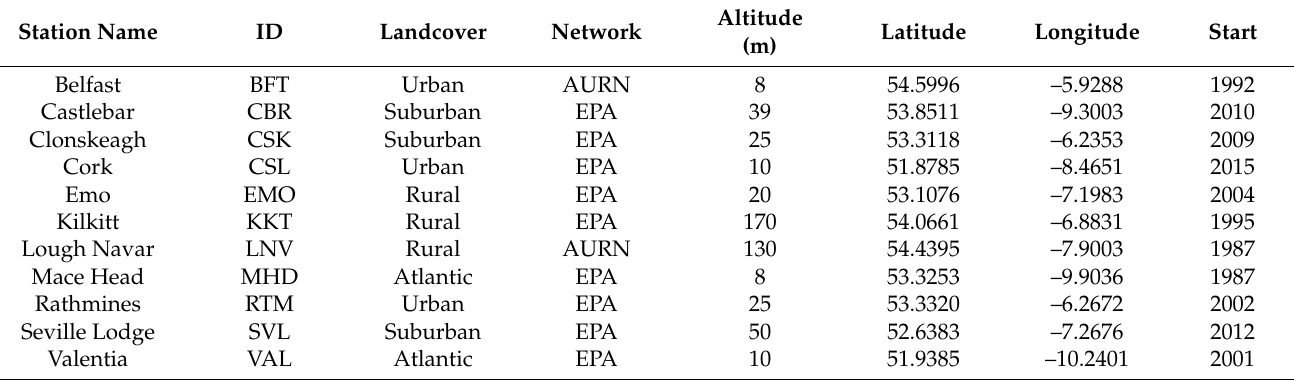
Table 1. Ambient air quality monitoring stations measuring tropospheric ozone that meet the minimum data threshold of five years (2015–2019), with location information, measurement network (Irish Environmental Protection Agency (EPA), United Kingdom Automatic Urban and Rural Network (AURN)) and first year of observations.